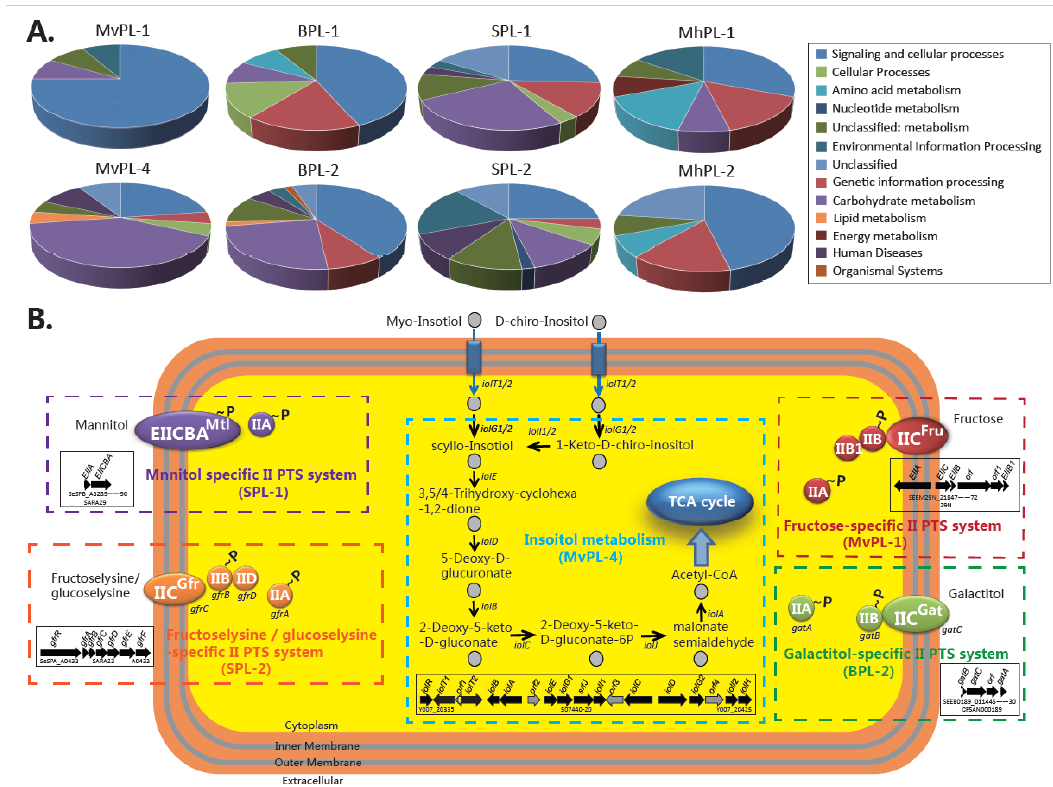
Figure 3. Functional enrichment of the lineage-specific genomic contents in the KEGG annotation.